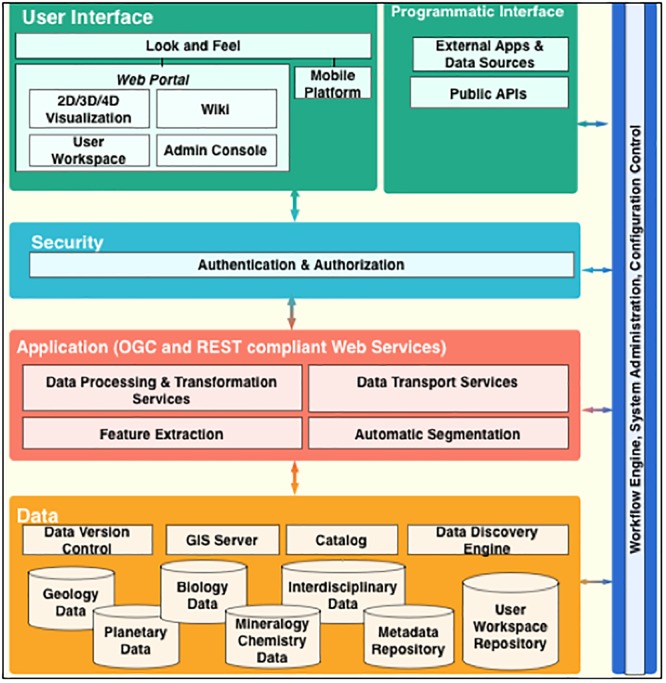
Conceptual AIS data system architecture that could integrate user workflow and astrobiologic data and spatial context across multiple scales.